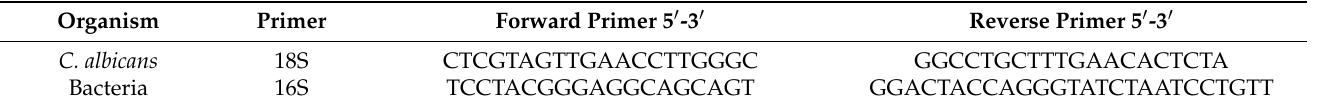
Table 4. Primer sequences used for compositional analysis of biofilm